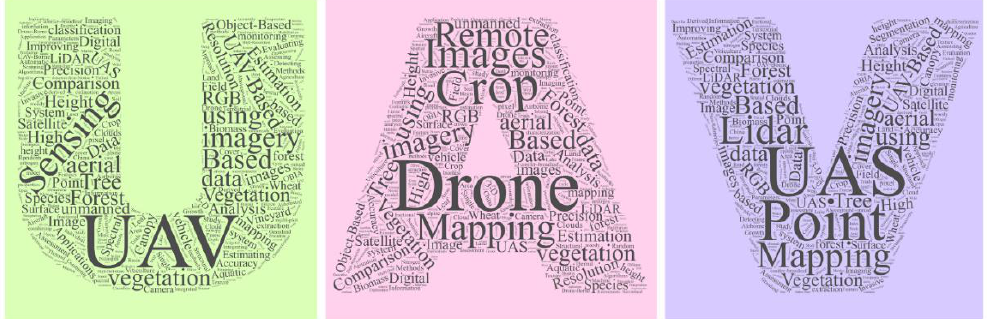
Figure 4. Frequency of keywords used within total searched papers (Tag cloud). The bigger the font size, the higher the frequency of usage.